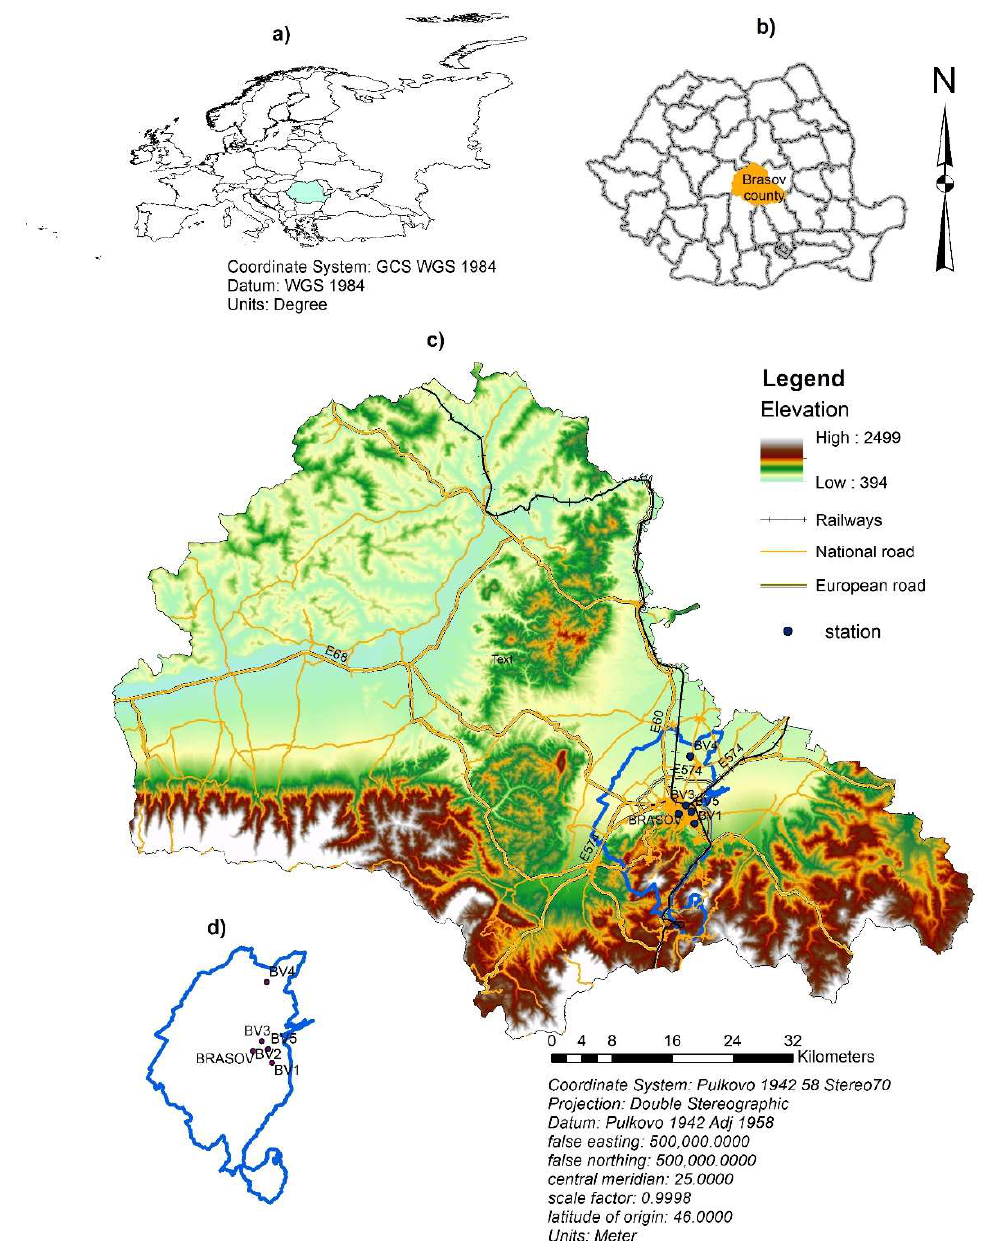
Figure 1. Location of Brasov County and air quality measurement stations: ( a ) map of Europe and the border of Romania; ( b ) map of Romania and the border of Brasov County; ( c ) relief, roads and railways traffic map of Brasov County and the location of monitoring stations; ( d ) Brasov metropolitan area.